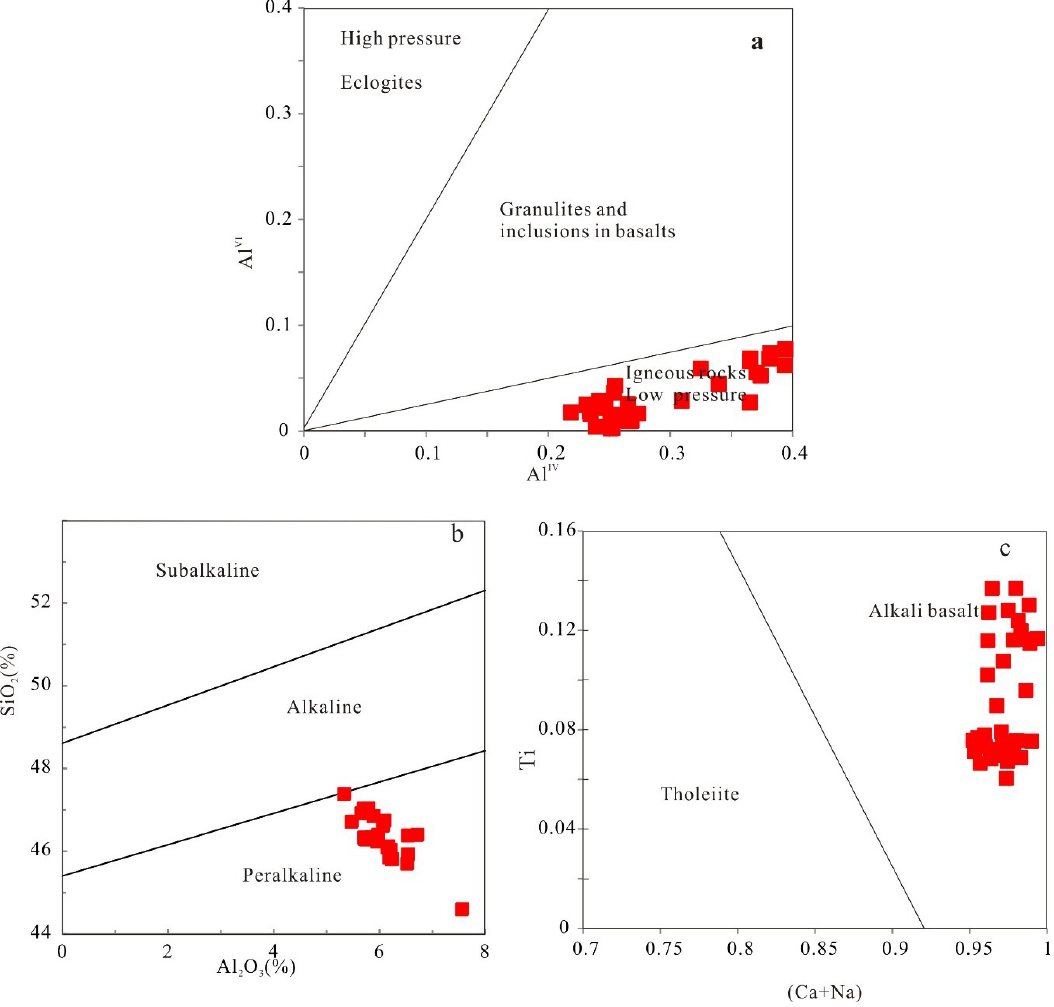
Figure 7. ( a ) Compositions of clinopyroxenes in the Al VI (apfu) versus Al VI (apfu) discrimination diagrams (after Aoki and Shiba, [68]). ( b ) SiO 2 -Al 2 O 3 discrimination diagrams for clinopyroxenes (after Leterrier et al. [28]); ( c ) Plot of clinopyroxenes on the (Ca + Na)-Ti discrimination diagram (after Leterrier et al. [28]).